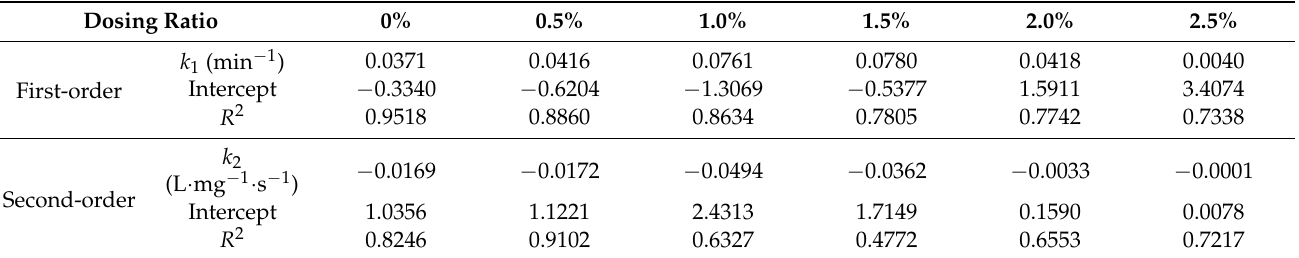
Table 2. Kinetic parameters of nitrate removal by aerobic denitrification flora under different bagasse dosing